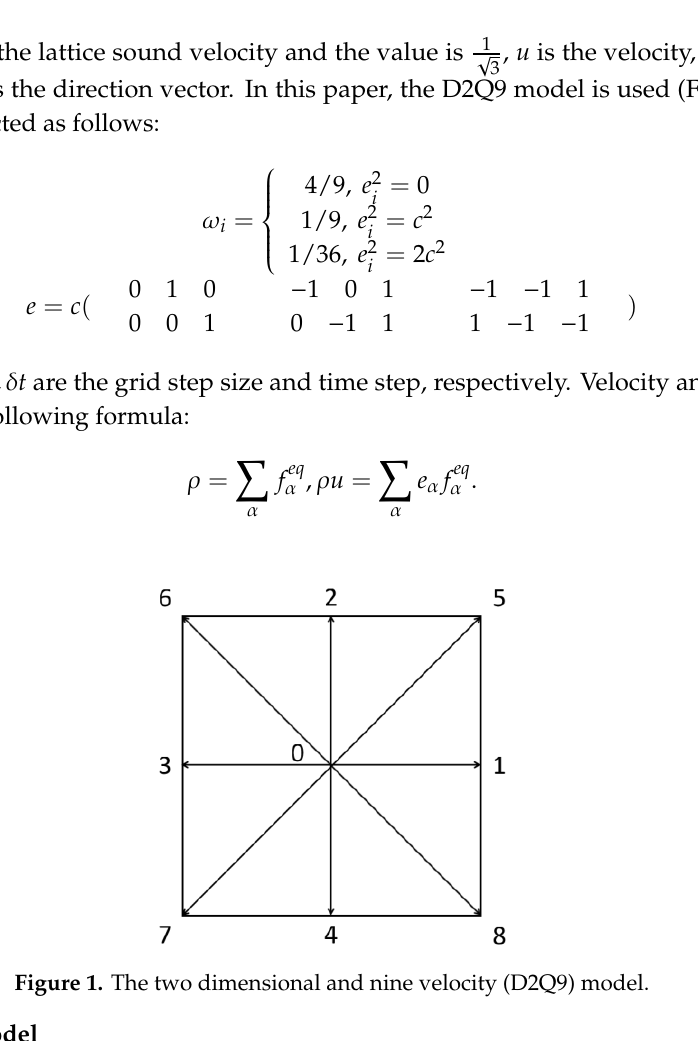
Figure 1. The two dimensional and nine velocity (D2Q9) model.